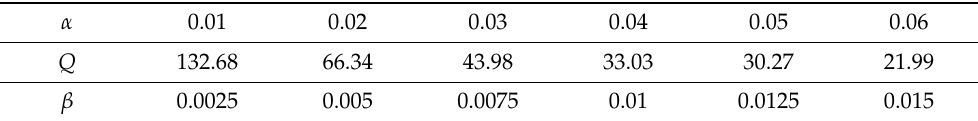
Figure 4. The forced frequency response of the cavity under the excitation 1 N and with the sound absorption coefficient of the cavity α v = 0.01. Table 2. The different sound absorption coefficient of acoustic materials and the corresponding quality factor and specific impedance ratio.